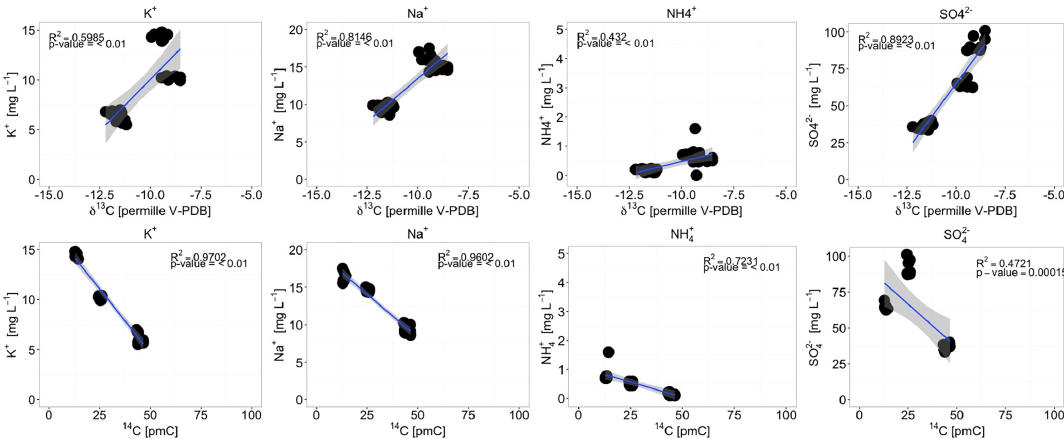
Figure 7. Correlations between elemental concentration in Group 2 and 3 wells and measured δ 13 C DIC and 14 C DIC values.